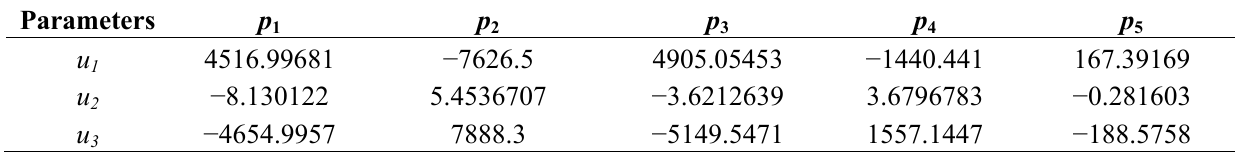
– p coefficients for computing rated wind 1 5